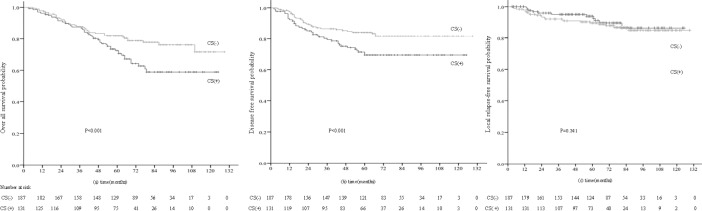
(a) Overall, (b) distant metastasis-free and (c) local relapse-free survival curves for the 318 patients with T4 NPC with and without cavernoussinus invasion (CSI).